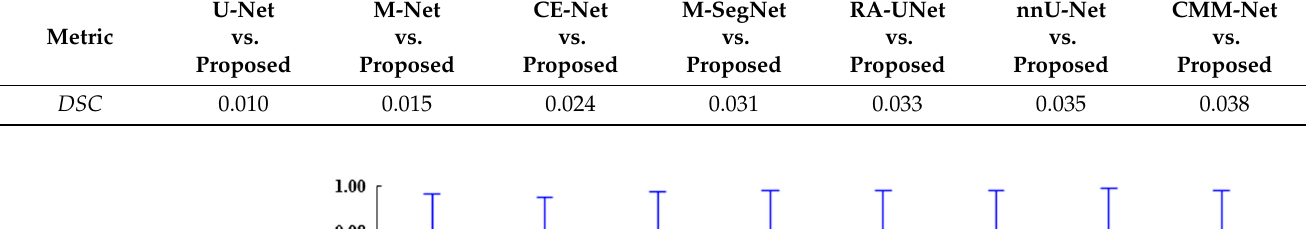
Table 3. p -values from Wilcoxon rank-sum tests for the DSC metric using the PH2 dataset.